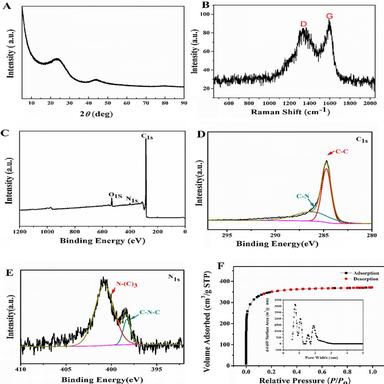
(A) XRD pattern of N-CCs, (B) Raman spectrum of N-CCs, (C) XPS spectrum of the N-CCs and (D) N2 adsorption-desorption isotherm of the N-CCs, the inset is the pore size distribution for the N-CCs (slit pore geometry).